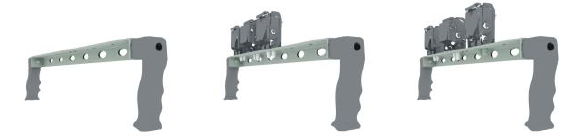
Figure 4. Model from reverse engineering